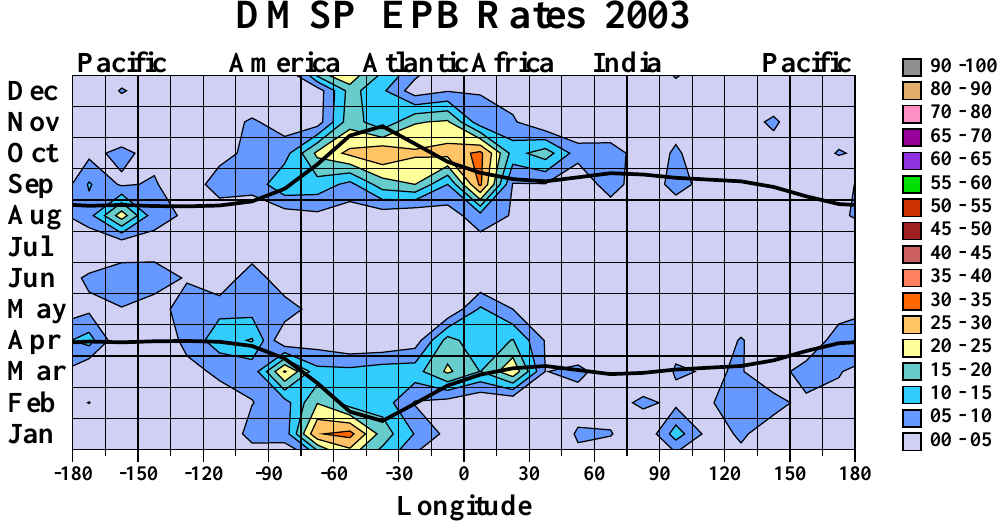
Fig. 9. EPB rates for transition year 2003 were higher in the Atlantic-Africa sector late in the year because of the number of EPBs during the October–November solar storms.